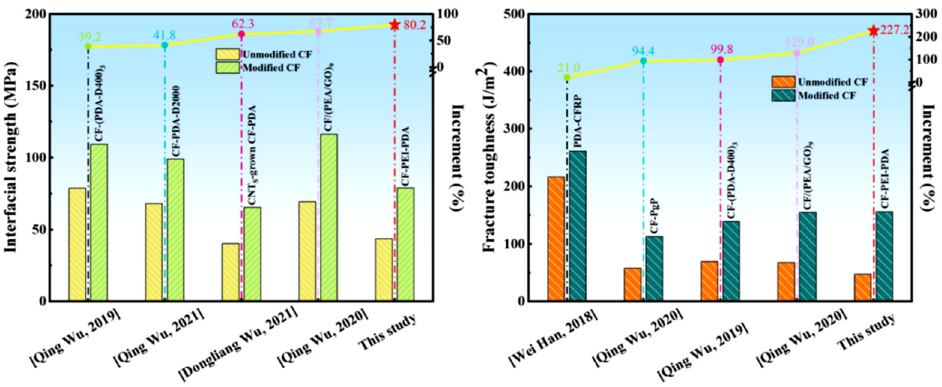
Figure 10. Cross-section SEM images and the carbon element distribution of the CF/EP composite for: ( a , b , c ) Unmodified CF/EP, ( d , e , f ) CF-PEI/EP and ( g , h , i ) CF-PEI-PDA/EP.